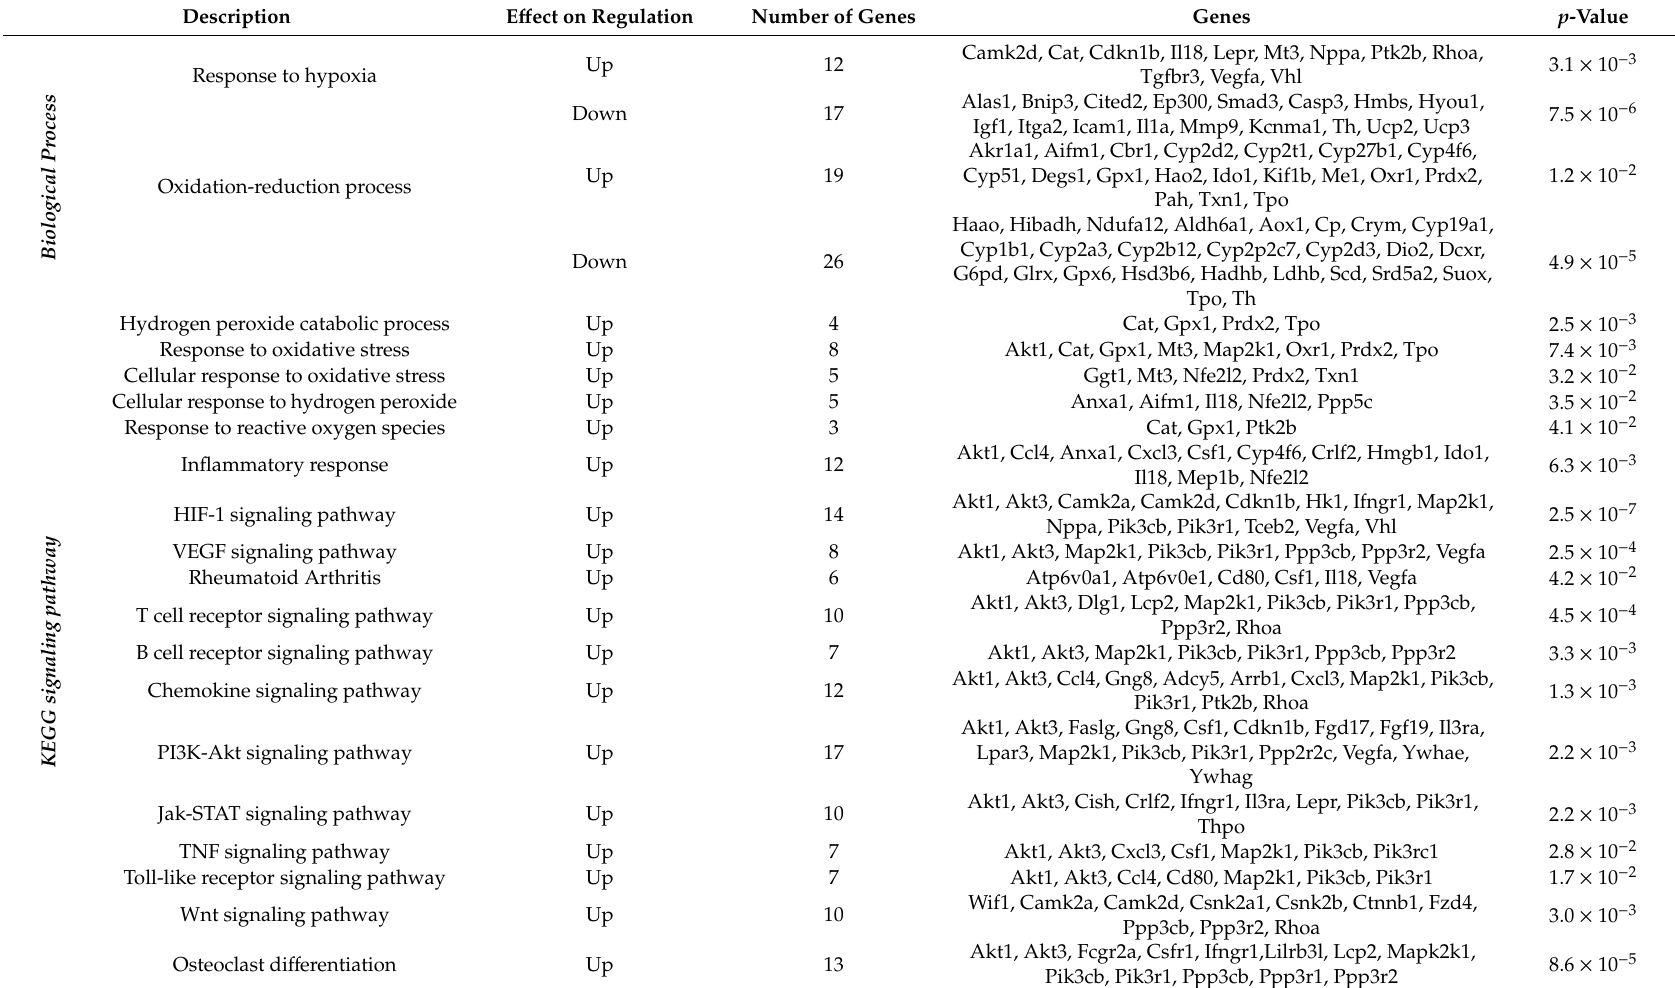
Table 1. Di ff erentially expressed genes by physical exercise associated with pathogenic processes in Rheumatoid Arthritis.